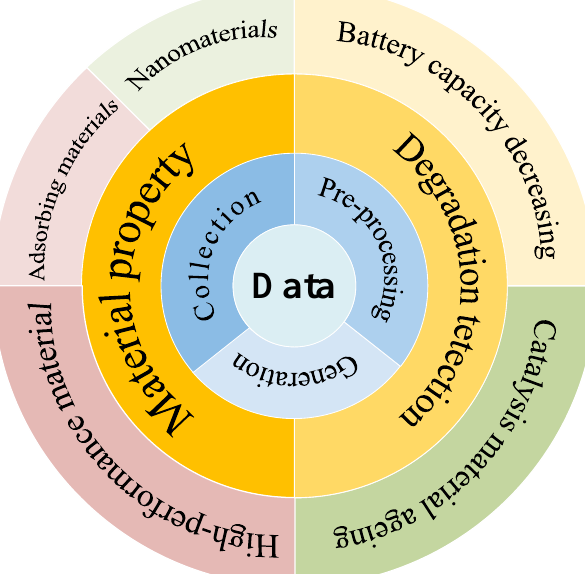
Figure 1. An overview of the components of machine learning for materials’ performance prediction. Data are at the heart of performance prediction, including data acquisition, data generation, and preprocessing. Based on the correlation between the properties derived from the data, predictions can be made for novel material properties (nanomaterials, adsorbing materials, high-performance materials, etc.) and degradation detection (decreasing battery capacity, catalysis material aging, etc.). It is worth pointing out that the predicted fields that can be obtained are not limited to the tasks illustrated above in this schematic, but also include other aspects such as atomic bonding en- ergies, thermodynamic properties, etc.